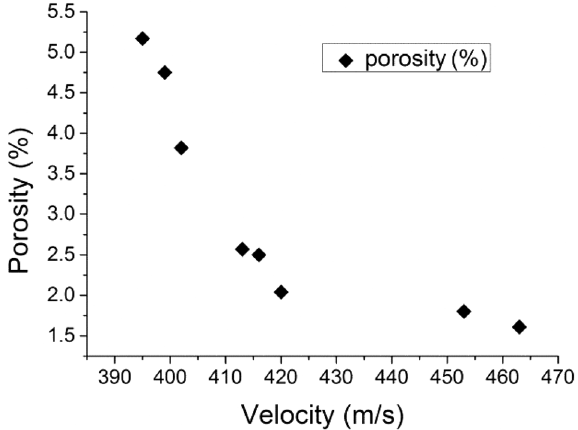
Figure 16: Porosity of coatings which formed by continuous particles impacted on stainless steel substrate with various